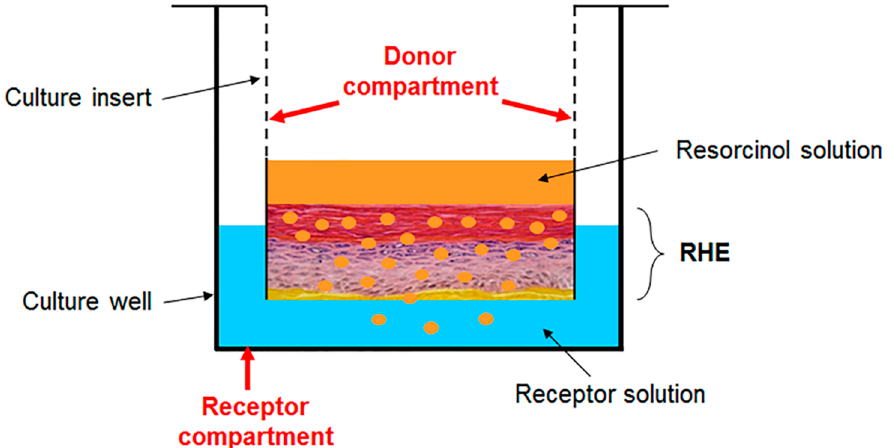
Figure 1. Schematic representation of a well, part of a 12-well culture plate, used as a diffusion cell for the exposure and permeation of resorcinol through the EpiSkin™ reconstructed human epidermis (RHE). The culture insert serves as the donor compartment, whereas the well itself serves as the receptor compartment.